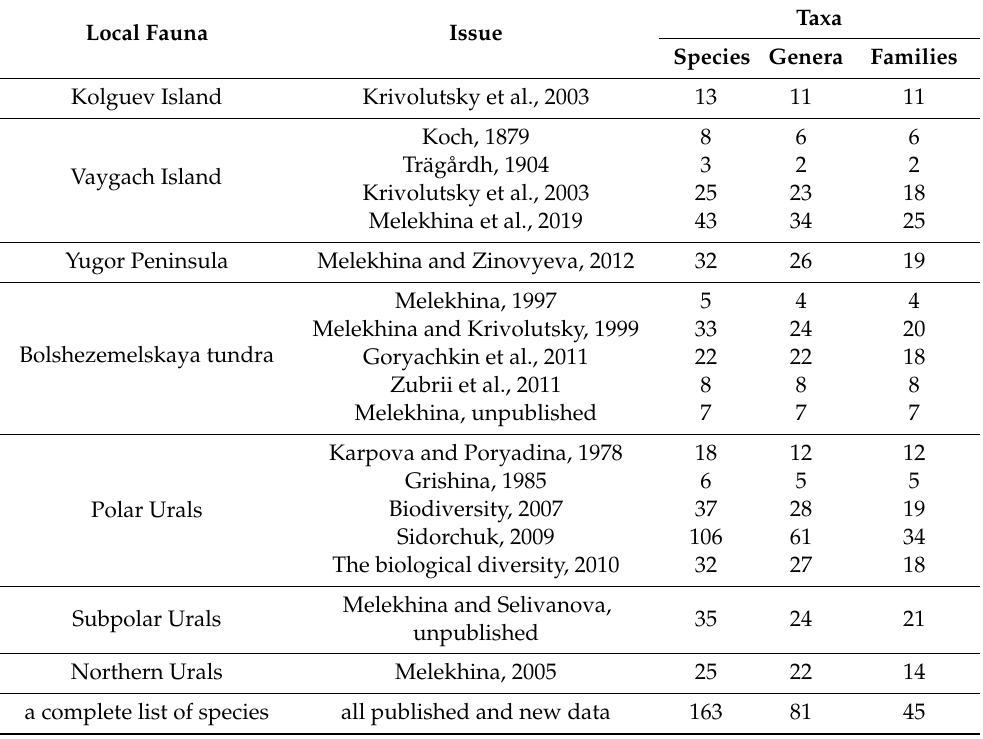
Table 1. Number of taxa of oribatid mites in the local fauna of East European tundra. Local